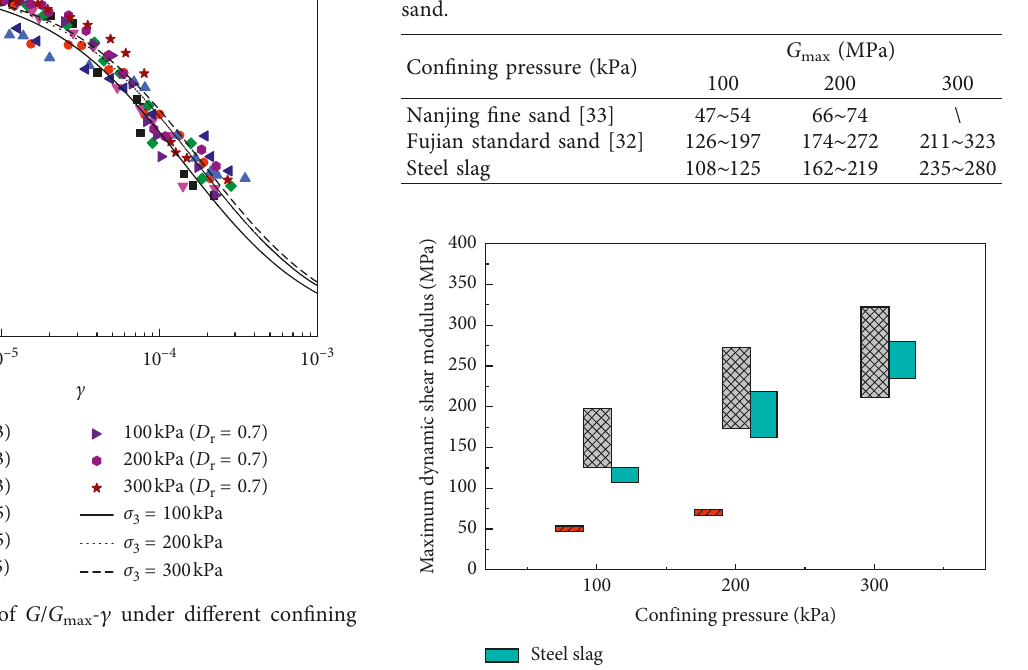
max for steel slag, fine sand, and standard